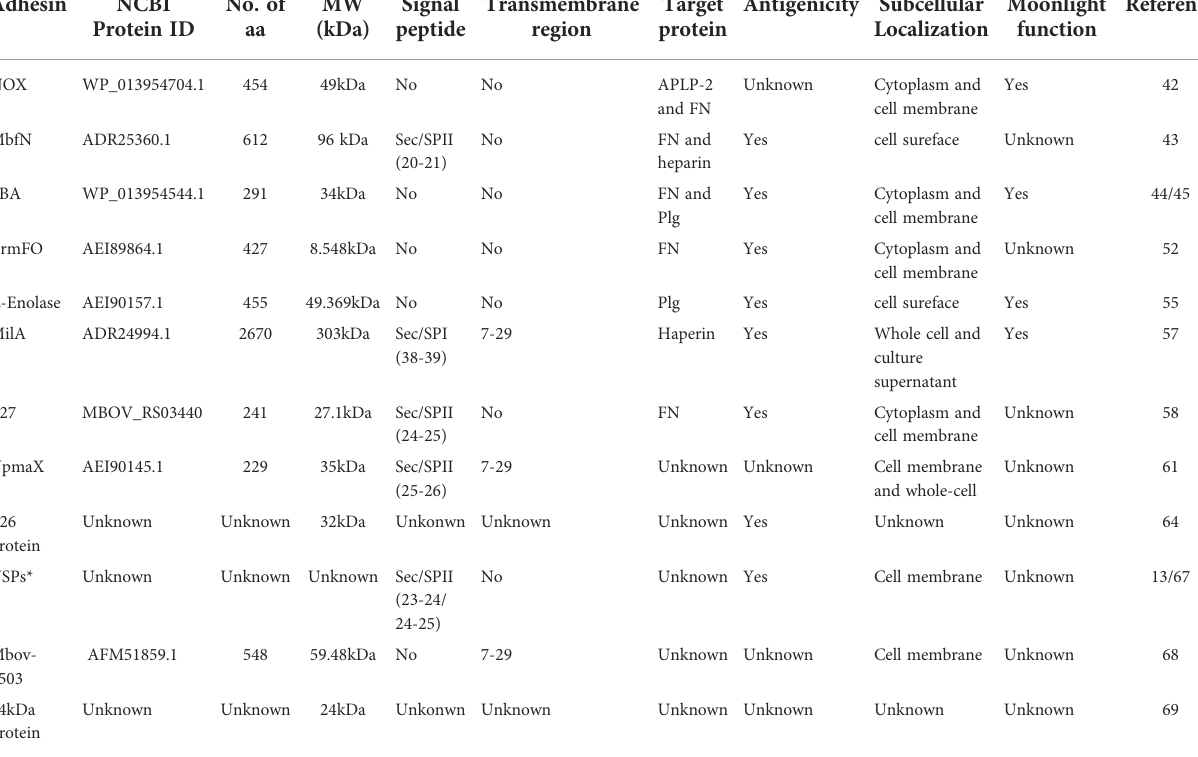
TABLE 1 Summary of M. bovis adhesin information. Adhesin